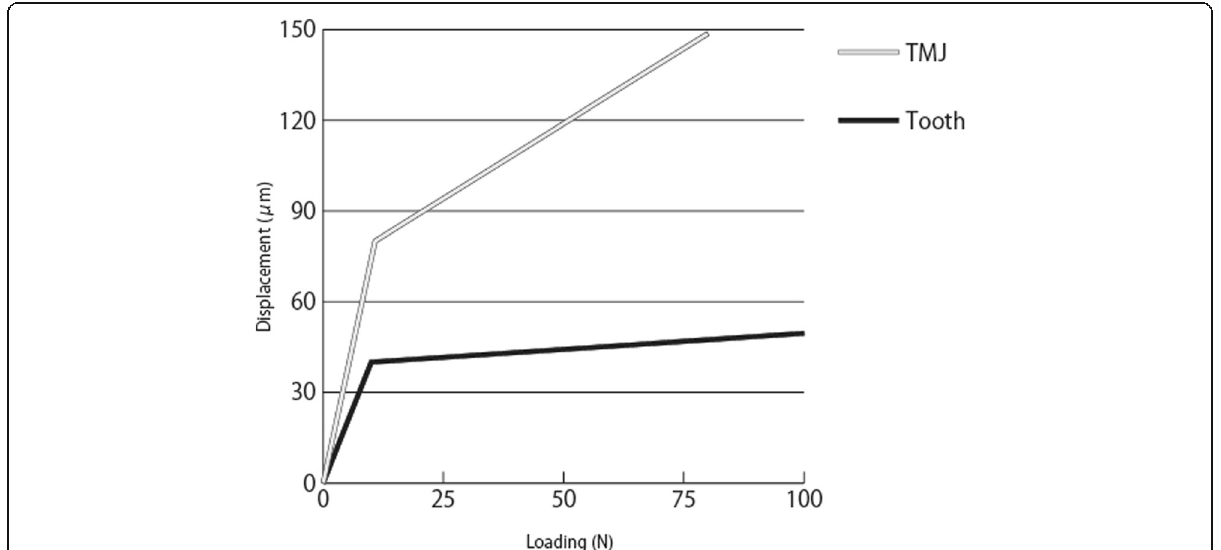
Fig. 2 Load displacement curves of springs